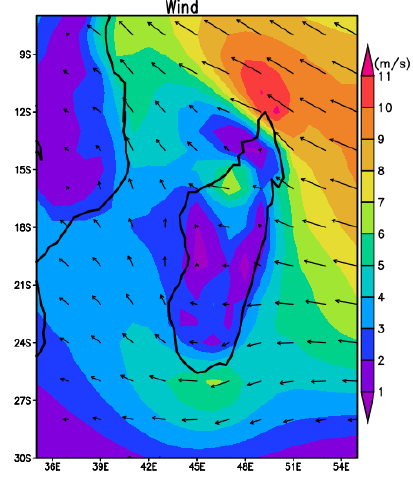
Figure 3. Nine year (2000-2008) average 975 hPa wind (m/s) during June–September months from ERA data over the Madagascar and its surrounding